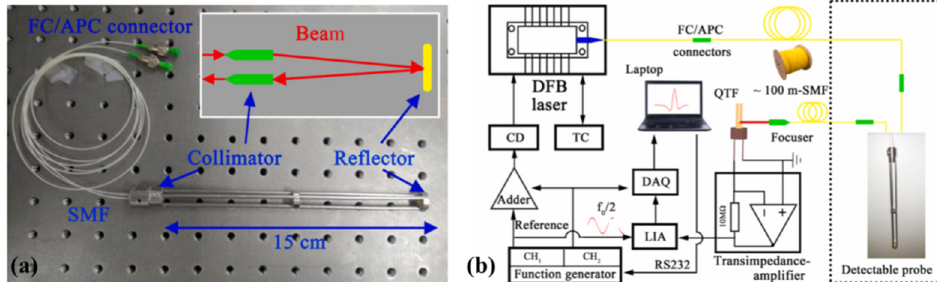
Figure 14. ( a ) The principle and photograph of the fiber-coupled sensing probe. ( b ) Experimental setup of the fiber-coupled sensing probe-based LITES sensor system. DFB laser: distributed feedback diode laser; CD: laser current driver; TC: laser temperature controller; DAQ: data acquisition card; LIA: lock-in amplifier; QTF: quartz tuning fork; SMF: single mode fiber. Reproduced with permission from Ref. [135]. Copyright 2021, copyright Elsevier.